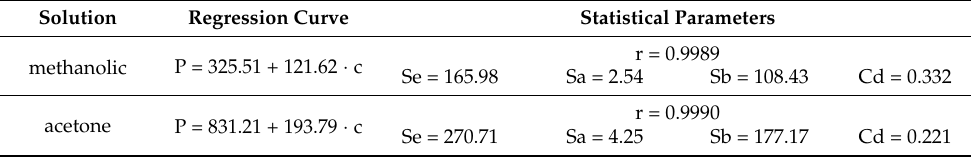
Table 1. Linearity range determined for the ceftobiprole solutions.